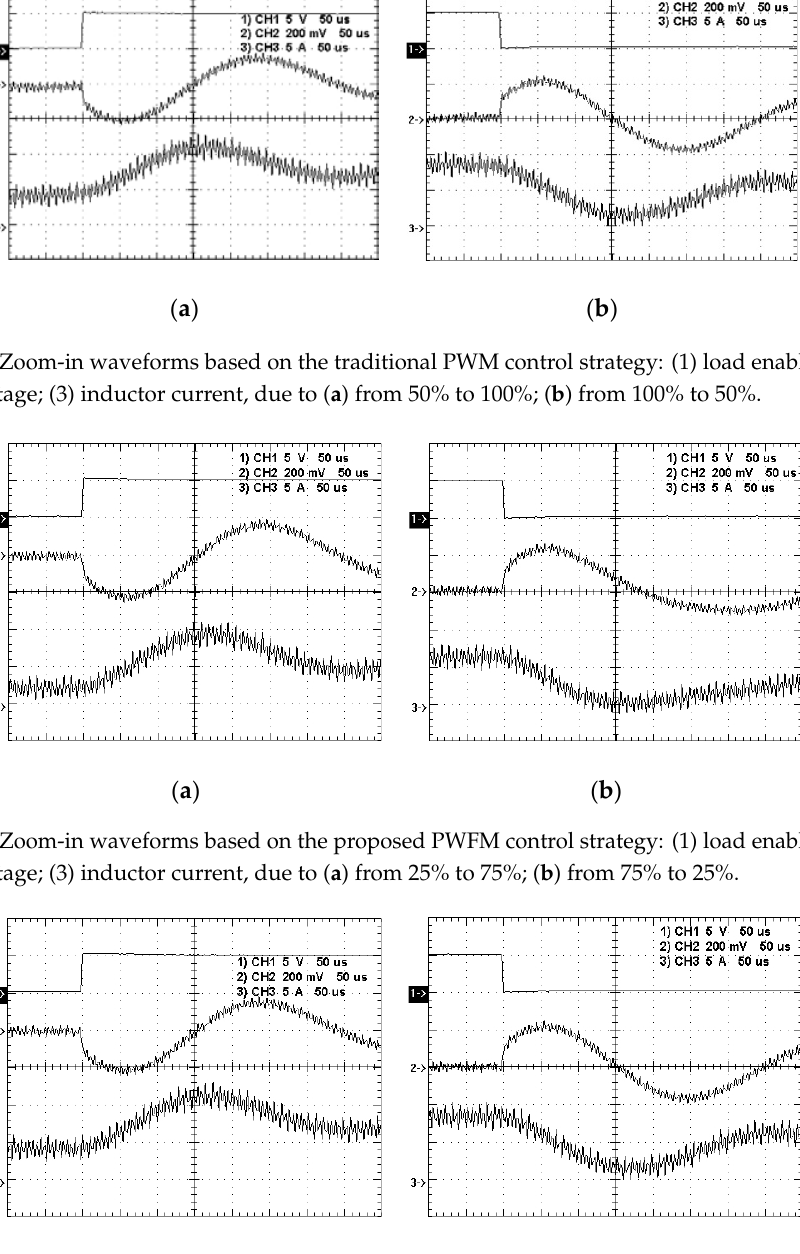
Figure 19. Zoom-in waveforms based on the proposed PWFM control strategy: (1) load enable; (2) AC